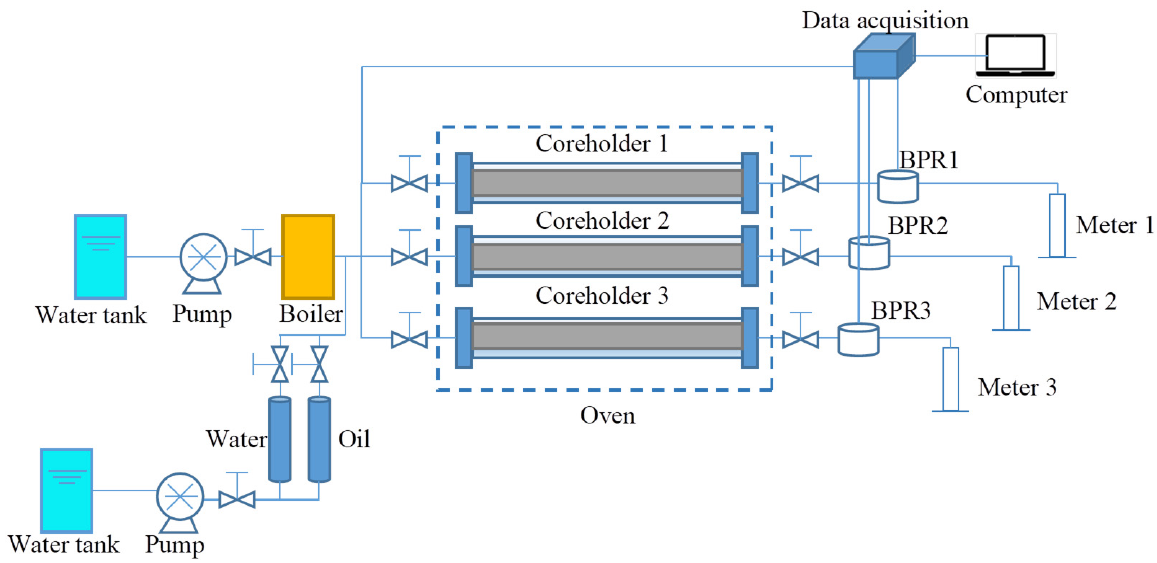
Figure 2. Schematic of experimental setup for 3-tube coreflooding experiments.